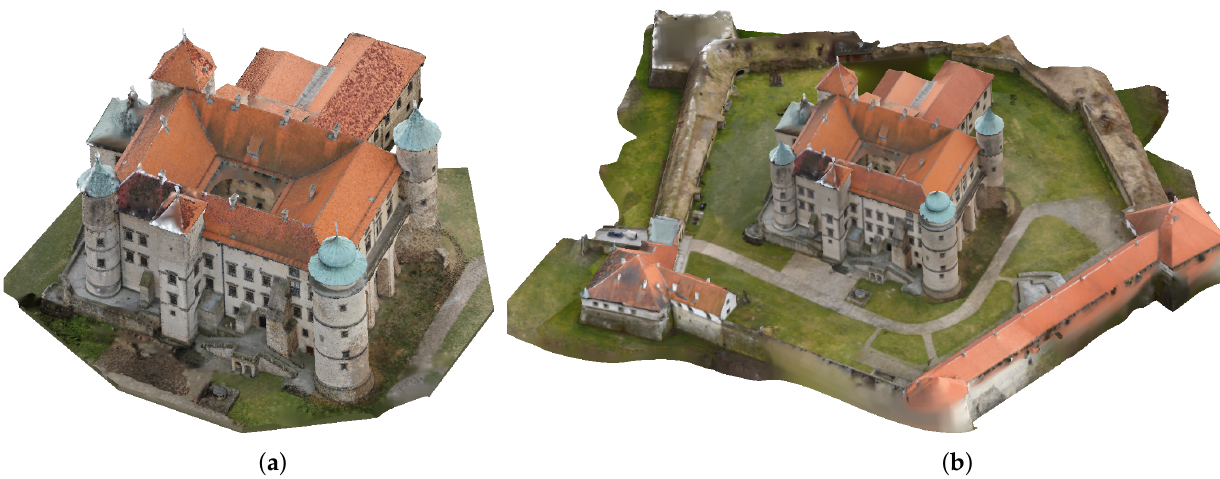
Figure 14. Polygon models of the castle in Nowy Wi´snicz: only the building (4,133,352 faces) ( a ); the building with fortifications (1,966,487 faces) ( b